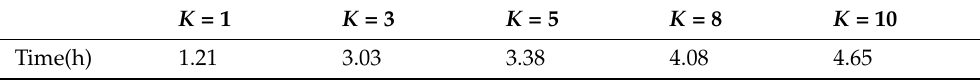
Figure 5. Trend of FID and PixelACC(%) scores for the SAM-GAN- K ( K = 1, 3, 5, 8, 10) model on the test set. Table 5. Time required to train the SAM-GAN model for different K values.